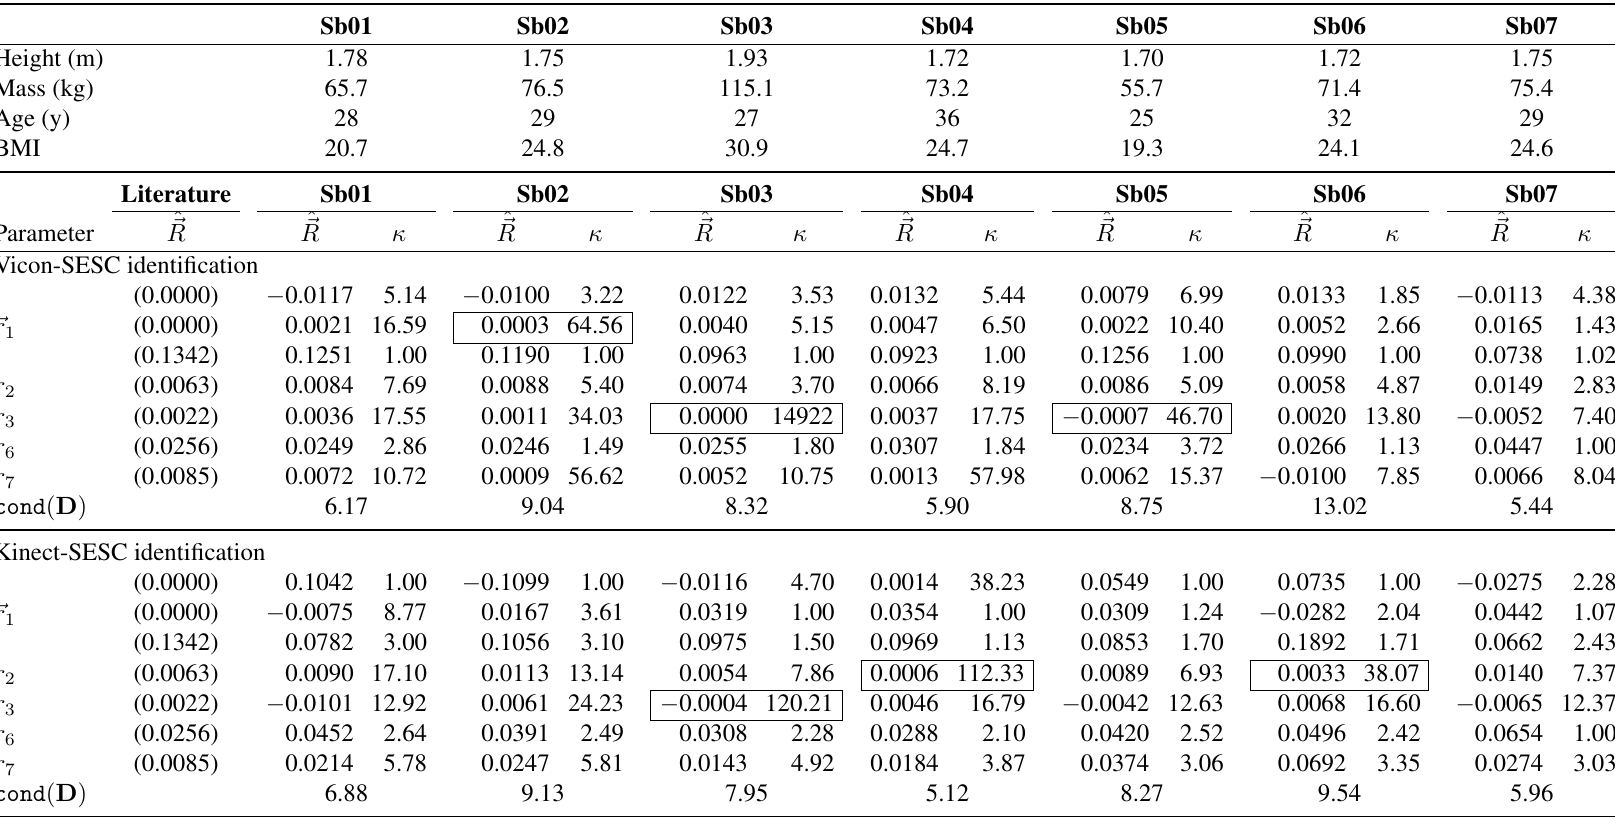
Table 1. Subject information and SESC identified parameters using the Vicon and Kinect data. The parameter vector subject height to show the differences with literature values. We show the ratio of the parameter relative standard deviations ( (cid:20) ), as well as the condition number of the configuration matrix to evaluate the quality of the identification [30]. The highlighted values presented a p > 0 : 01 during a t -test, indicating that they were not significant to the